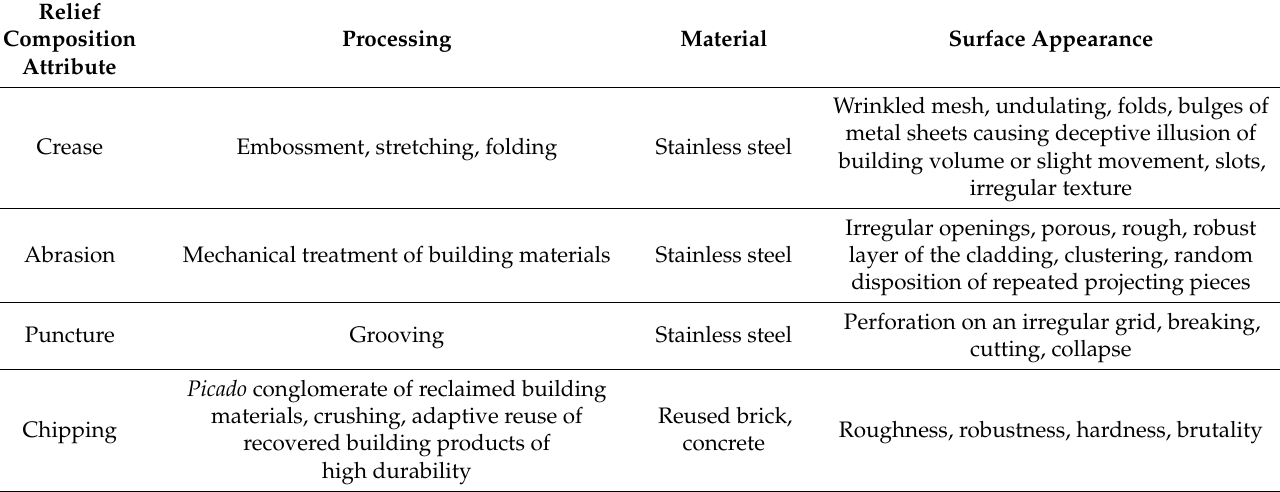
Table 2. Typology of relief composition in the ADAD